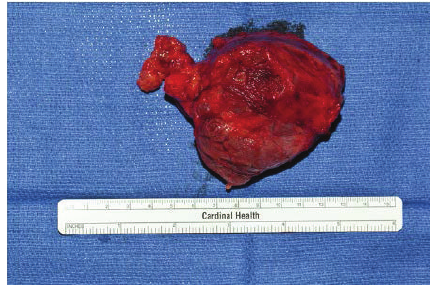
Figure 3: Gross pathologic specimen of the surgically resected parathyroid